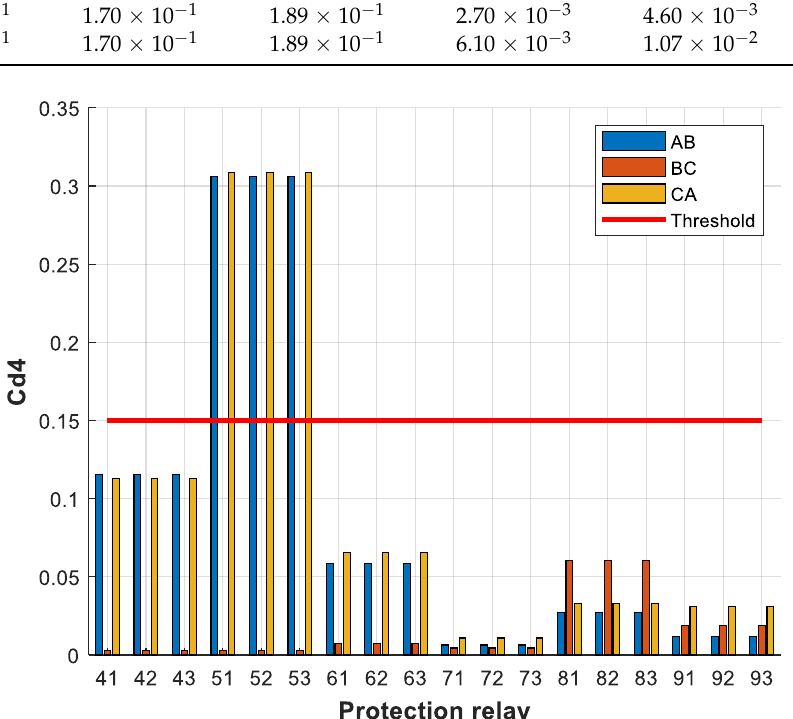
Figure 7. Differences in the voltage Cd4-dB3 at load A.